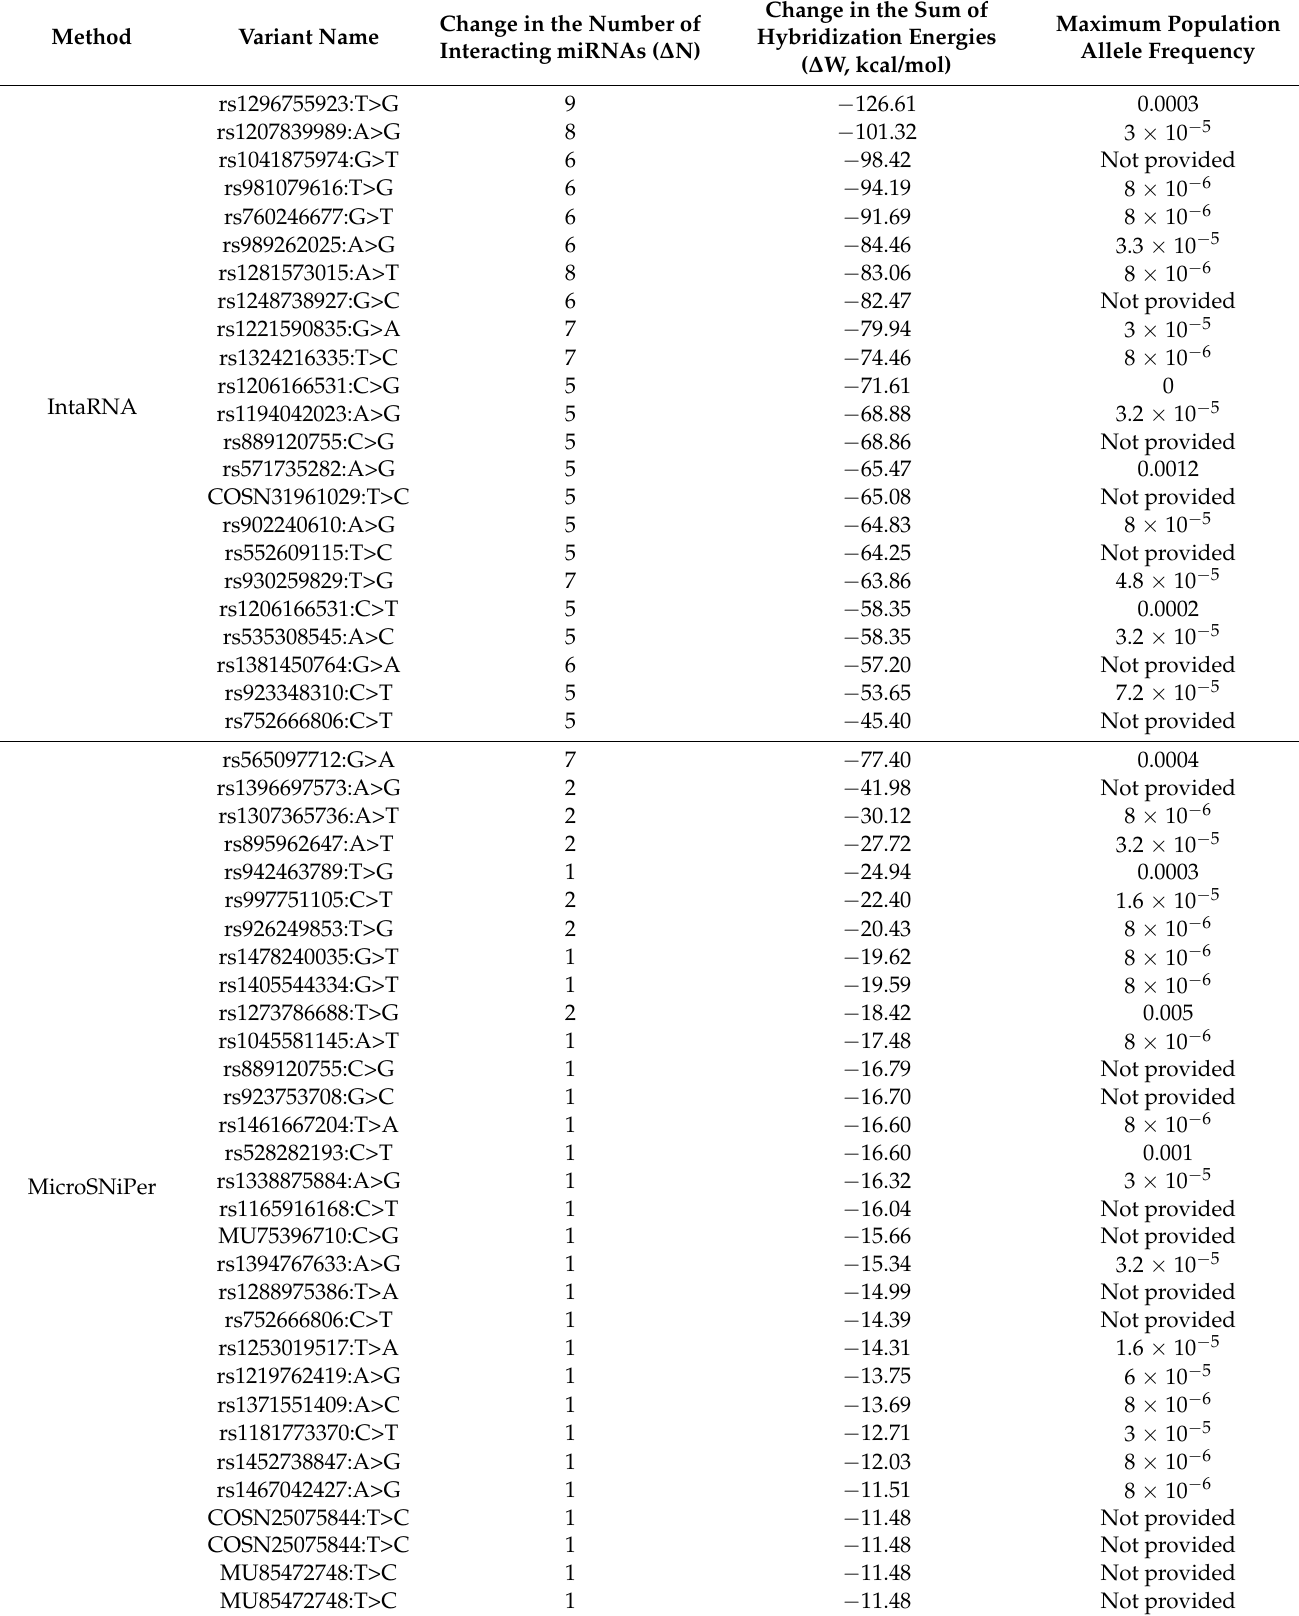
Table 2. The most effective variants predicted to downregulate the DICER1 expression in mesenchymal stromal cells (MSCs).